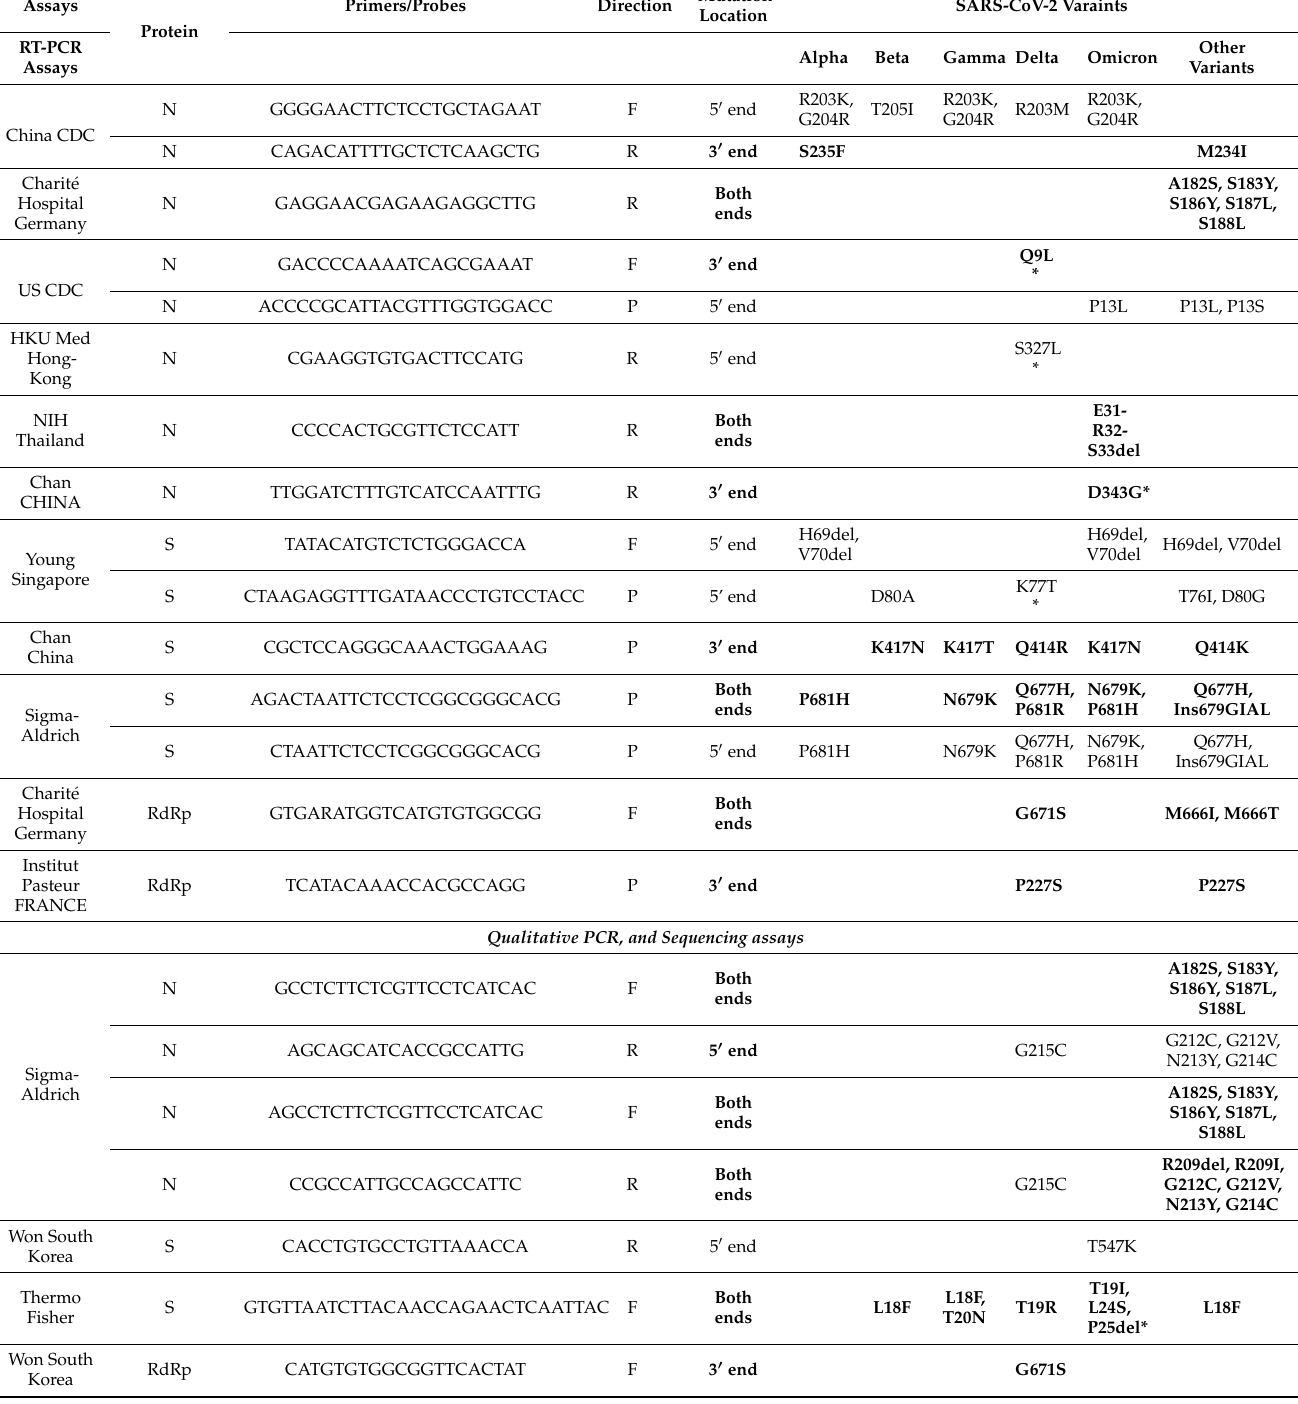
Table 2. Summary of SARA-CoV-2 specific variants mutations located in the